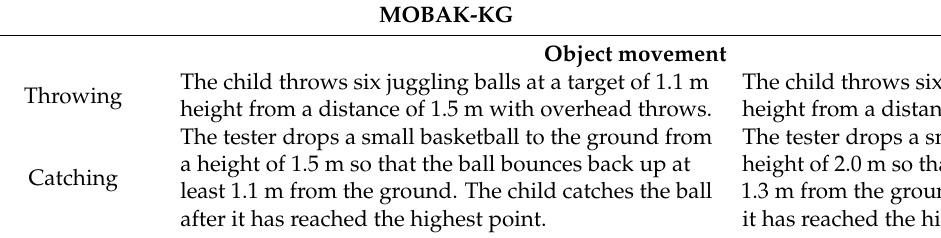
The child throws six juggling balls at a target of 1.1 m Throwing height from a distance of 1.5 m with overhead throws. The tester drops a small basketball to the ground from a height of 1.5 m so that the ball bounces back up at Catching least 1.1 m from the ground. The child catches the ball after it has reached the highest point.